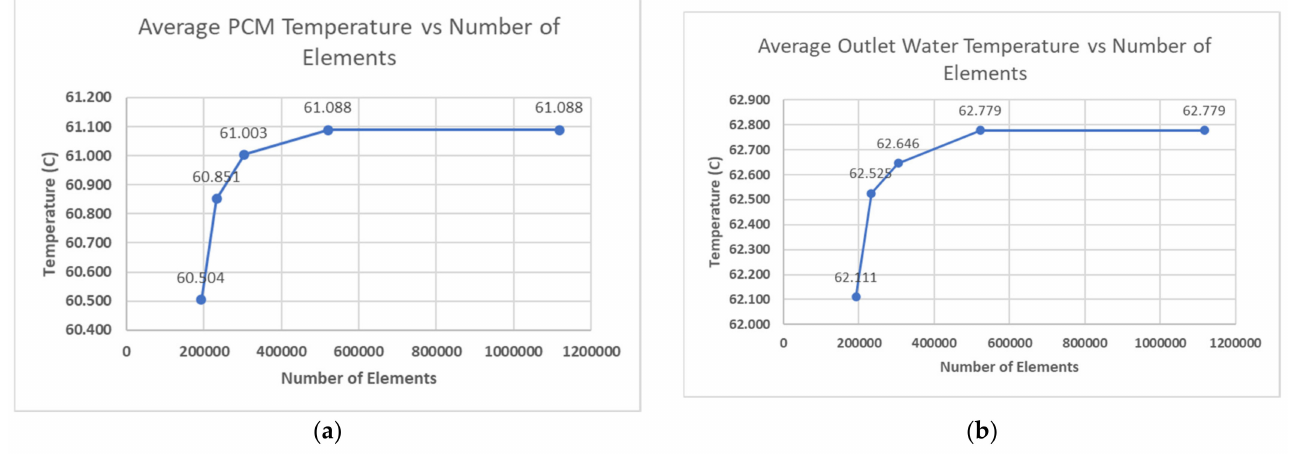
Figure 4. Mesh independence study, ( a ) average PCM temperature; and ( b ) average water tempera- ture versus number of elements used in the computational grid.